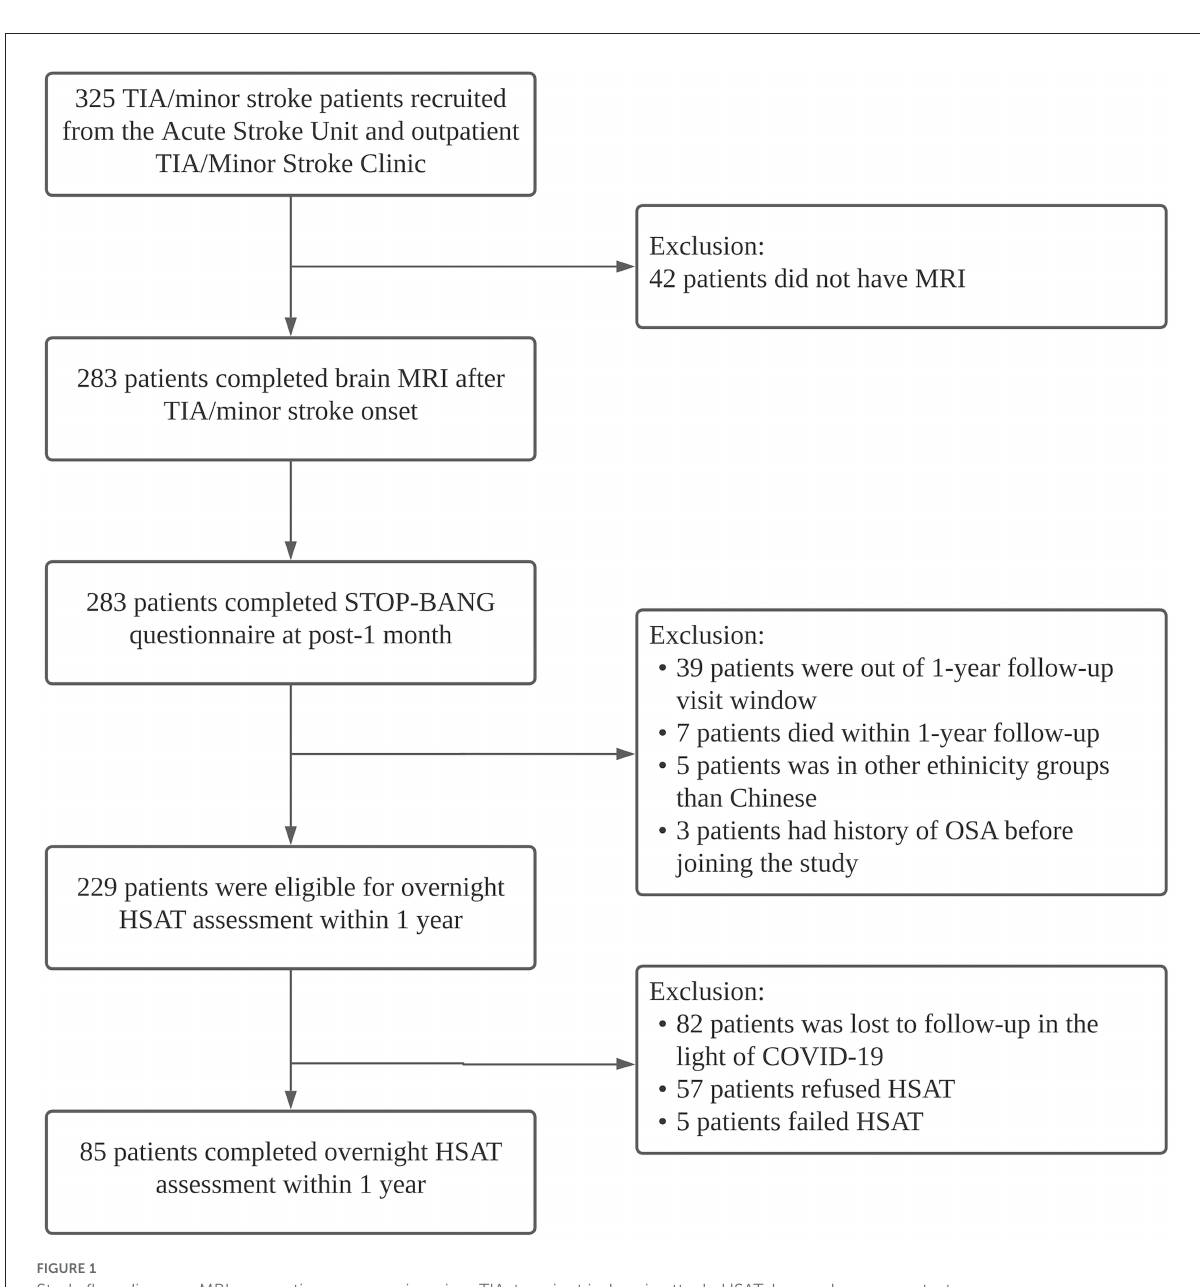
scales (25–27). The global burden of CSVD was